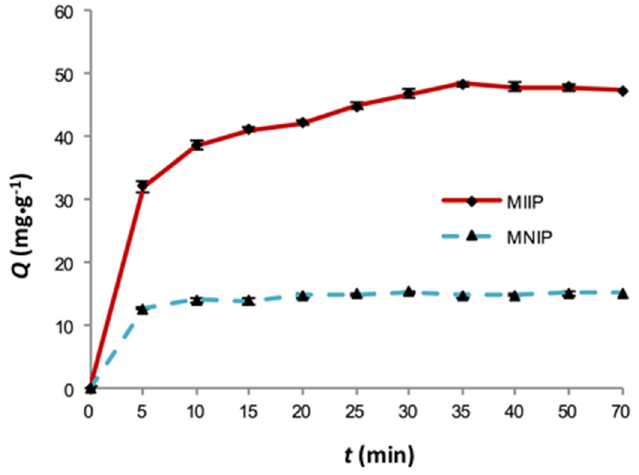
Figure 8. The adsorption dynamics curves of the MIIP and MNIP.